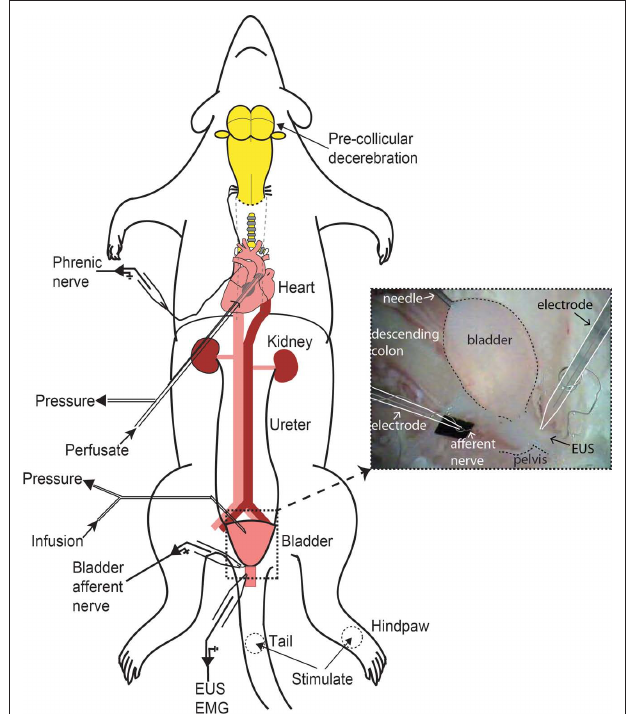
Figure 1 | Schematic of decerebrate arterially perfused rat (DAPr) in situ preparation for bladder studies. Shows the preparation with a double lumen cannula inserted via the left ventricle into the ascending aorta, allowing perfusate to be pumped into the arterial tree, as well as allowing continuous monitoring of perfusion pressure. Recording of phrenic nerve activity was used as a physiological indicator of brainstem viability. A needle (30G) inserted into the bladder dome allowed infusion of fluid and monitoring of intravesical pressure (see inset photograph of filled bladder). Simultaneous recordings of EUS–EMG activity and bladder afferent nerve were possible. Naturalistic stimuli could also be applied to the perineum, tail, or hindlimbs to evoke somatic and autonomic